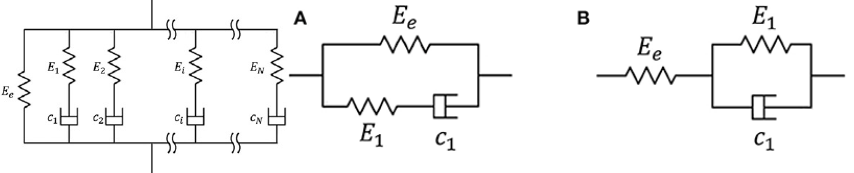
Figure 1. ( A ) Generalized Maxwell material model ( left ) with SLS or Zener model represented in Maxwell ( center ) and ( B ) Kelvin–Voigt ( right ) forms (Lin) [16].